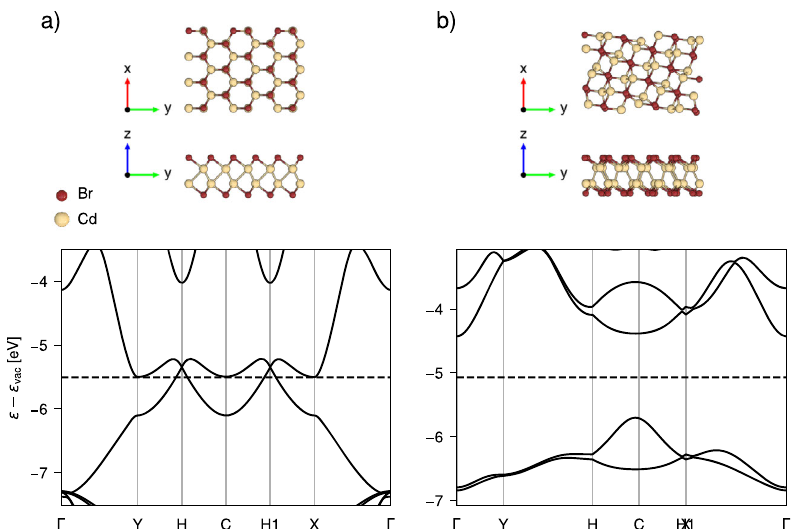
Fig. 7 Gap opening for CdBr. Extreme case of gap opening for the stable material (CdBr) where the difference in the gap between the initial unstable metallic phase ( a ) and the fi nal structure ( b ) is 1.28 eV.